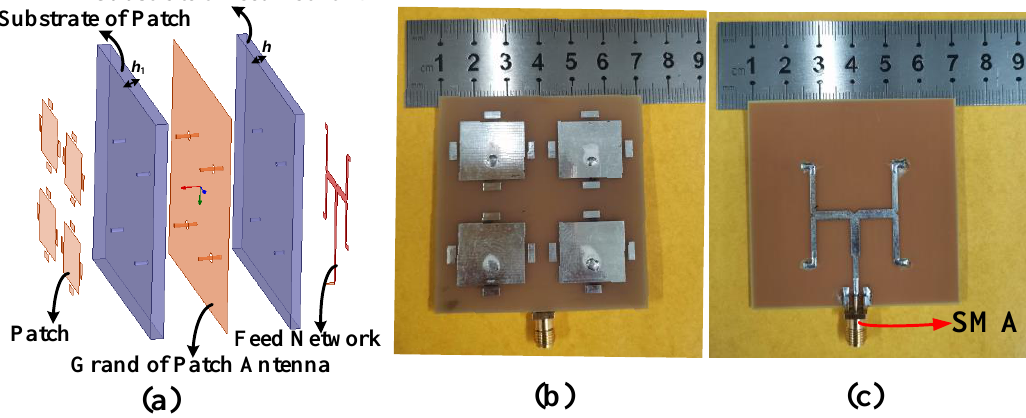
Figure 3. ( a ). Details of the simulation model (one smaller patch is connected to the larger main patch). ( b ). The return losses at different frequencies.